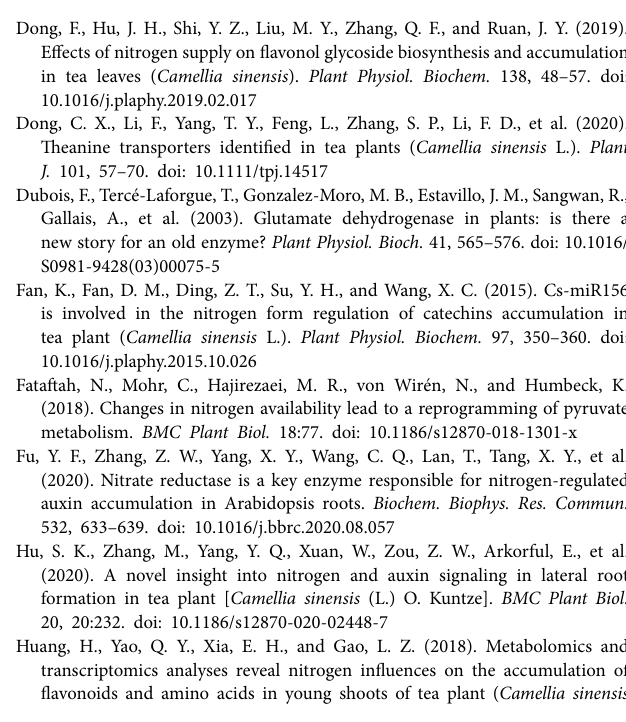
deprivation and resupply. Supplementary Table 7 | The related data of Co-expression network and correlation